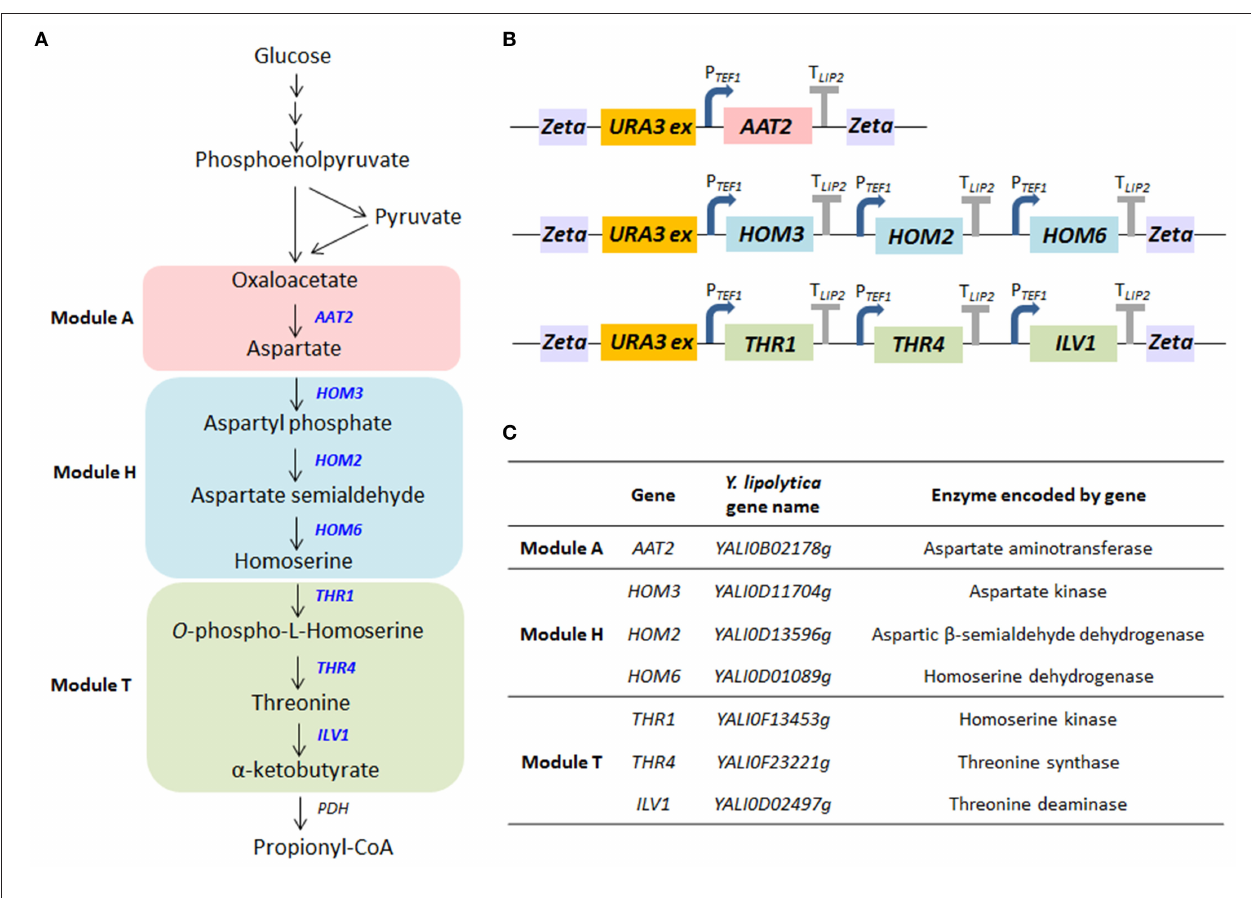
FIGURE 2 | The biosynthetic pathway for propionyl-CoA. (A) The metabolic pathway by which propionyl-CoA is synthesized from glucose. The genes overexpressed in this study are shown in blue. Pyruvate produced by glycolysis is converted to oxaloacetate by pyruvate carboxylase, and oxaloacetate is converted to threonine through the biosynthesis of aspartate and homoserine. Threonine deaminase subsequently generates α -ketobutyrate from threonine. Then, α -ketobutyrate is converted to propionyl-CoA by the pyruvate dehydrogenase (PDH) complex. (B) Structure of the multigene modules encoding enzymes in the aspartate/ α -ketobutyrate pathway that were constructed in this study. Each gene expression cassette included the native TEF1 promoter and LIP2 terminator. (C) The genes included in the modules and the enzymes they